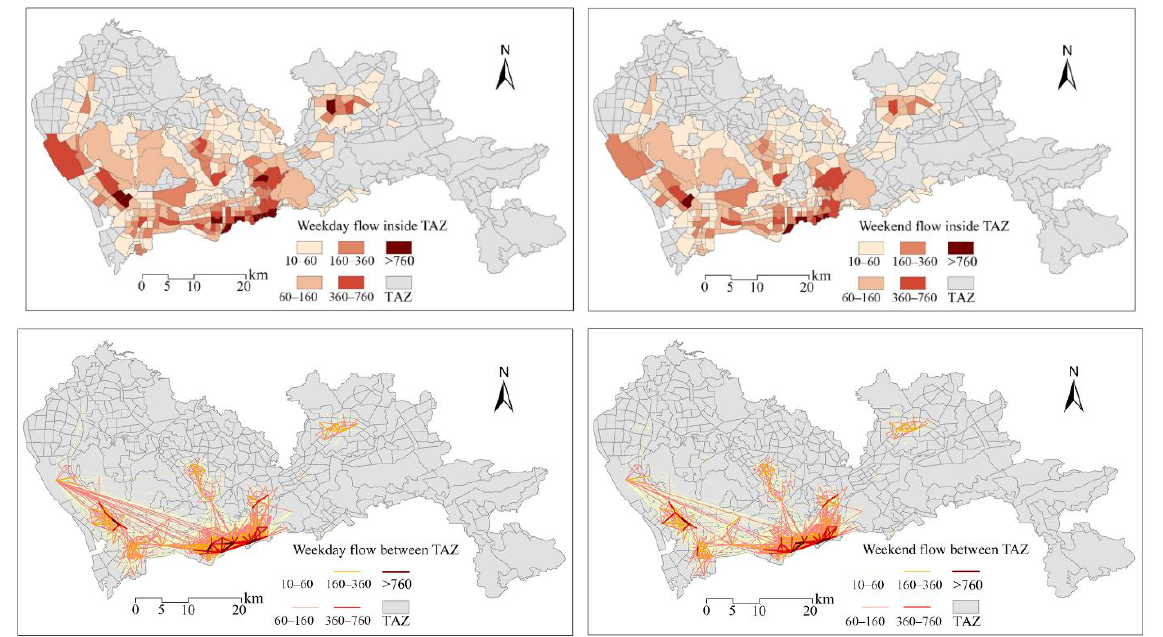
Figure A5. Trip flow diagram between and inside TAZs in Shenzhen.